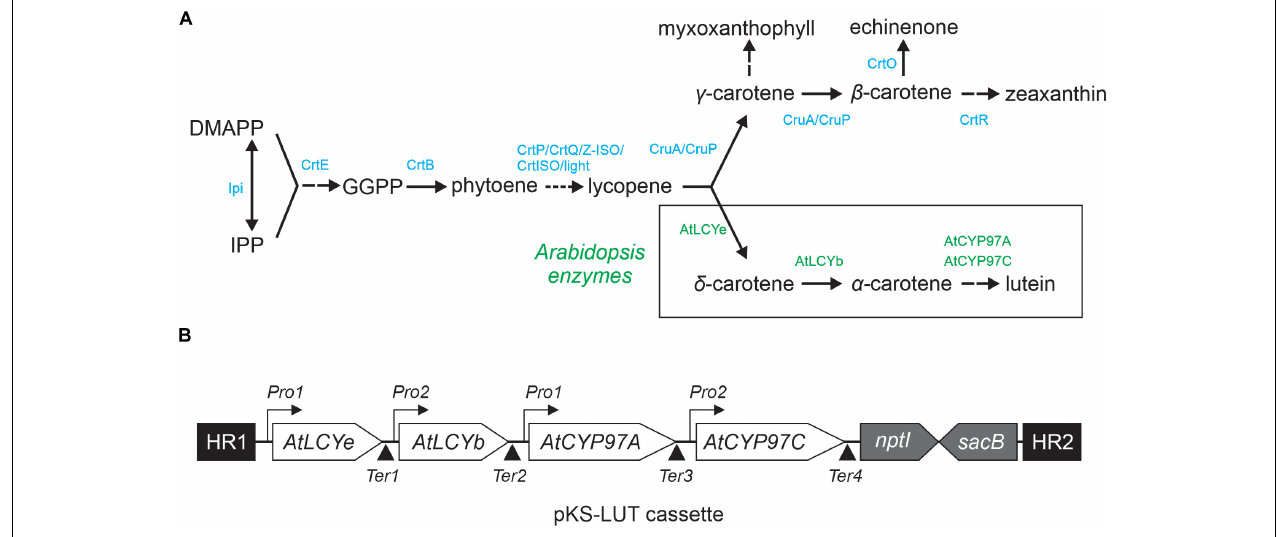
FIGURE 1 | Engineered lutein synthesis pathway in Synechocystis. (A) Endogenous carotenoid and engineered lutein synthesis pathways in Synechocystis . Two plant lycopene cyclases (AtLCYe and AtLCYb) and two hydroxylases (AtCYP97A and AtCYP97C) create a novel synthesis pathway that diverges from the CruA/CruP branch and converts lycopene to lutein. The endogenous Synechocystis and introduced Arabidopsis enzymes necessary for lutein production are marked in blue and green, respectively. Abbreviations: IPP: isopentenyl diphosphate, DMAPP: dimethylallyl diphosphate, GGPP: geranylgeranyl diphosphate, CrtE: geranylgeranyl diphosphate synthase, CtrB: phytoene synthase, CrtP: phytoene desaturase, CtrQ: zeta carotene desaturase, Z-ISO: 15- cis - ζ -carotene isomerase, CrtISO: cis -to- trans carotenoid isomerase, light: photoisomerization, CruA/CruP: CruA/CruP-type of lycopene cyclases (CruA: β - cyclase activity, CruP: not proven β - cyclase activity), CrtO: β -carotene ketolase, and CrtR: β -carotene hydroxylase. A more detailed overview of the carotenoid biosynthesis pathway in cyanobacteria is given elsewhere (Domonkos et al., 2013; Sugiyama and Takaichi, 2020). (B) Schematic representation of the four-gene pKS-LUT construct used for